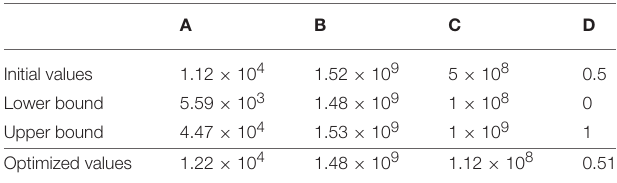
The second fitting curve is a sigmoid curve, which was derived from Equation